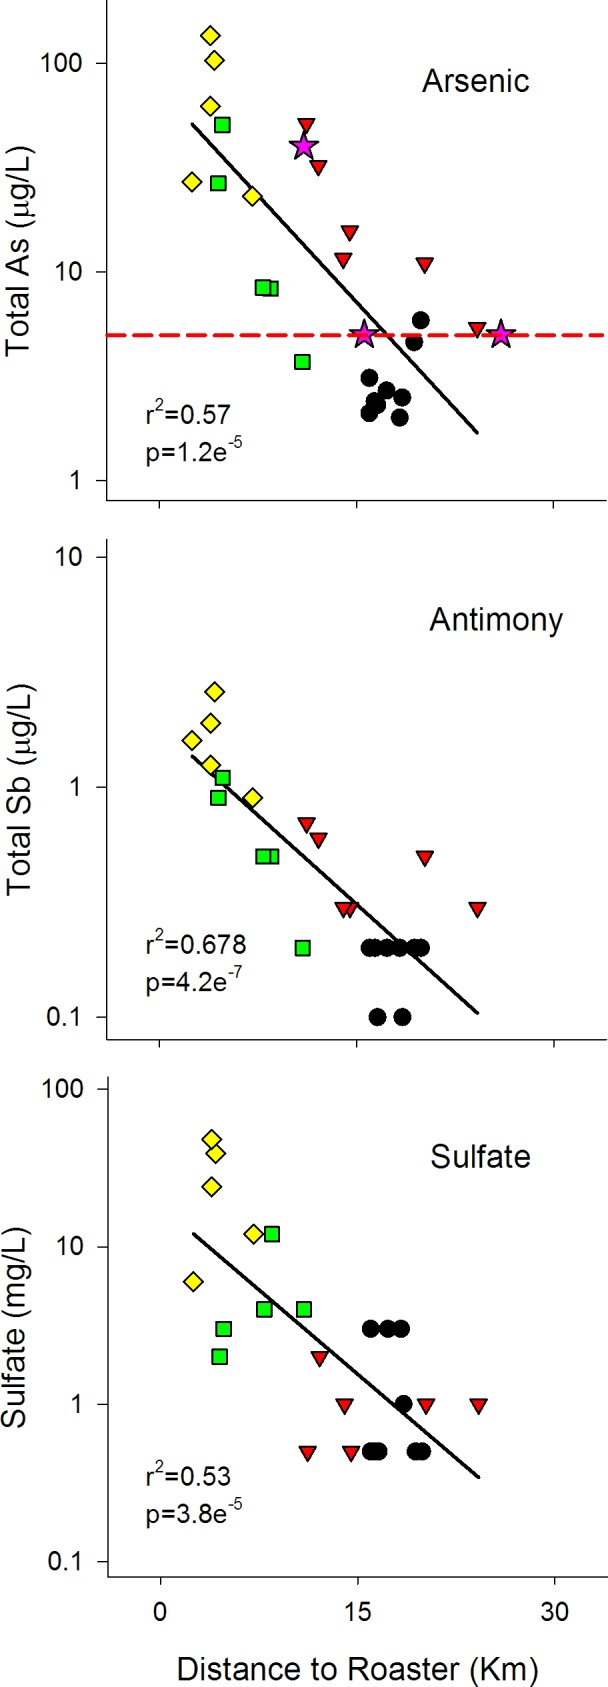
Ln-transformed lake water concentrations of total arsenic, total antimony, and sulfate in 25 lakes within the Yellowknife, NT, region.Lakes are plotted by underlying bedrock—Yellow diamond: Volcanic Yellowknife Bay Formation; green square: sedimentary Metaturbidites; red triangle: Granodiorite west; black circle: Granodiorite east; purple star: 3 undisturbed lakes from Wagemann et al 1978. The red dashed line indicates the 5 μg/L arsenic water quality guideline for the protection of aquatic life (CCME 1997), intersecting with the regression line at 17 km from the roaster.